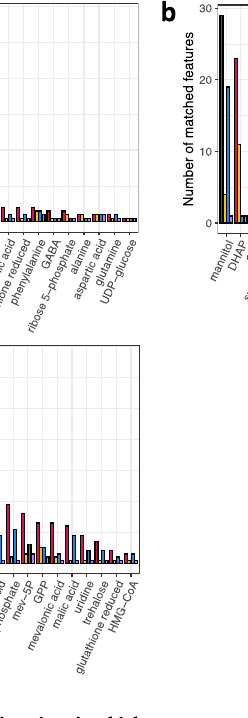
accurate mass to either RT or CCS reduced the number of matched features. By combining accurate mass with both RT and CCS, the number of possible features was reduced to one in most cases. These results illustrate the power of multi- dimensional separations to increase the annotation con fi dence and quantitation accuracy in metabolomics studies by resolving the high degree of structural diversity derived from isomers and isobars. Source data are provided as a Source data fi